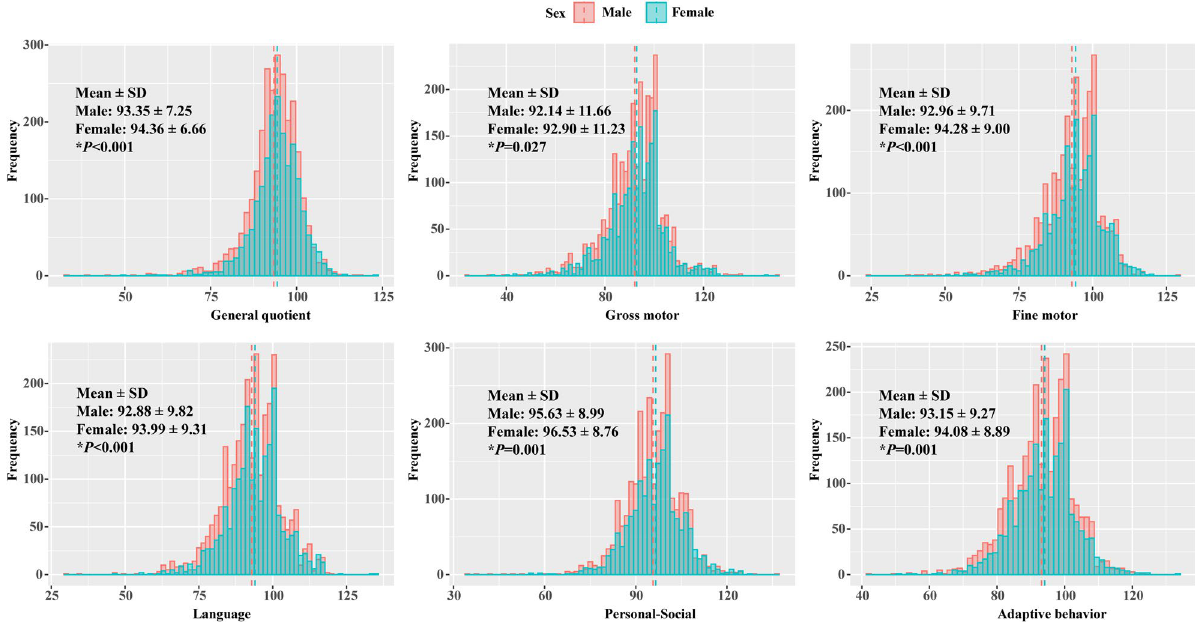
Figure 1. Distribution of CNBS-R2016 scores in different neurodevelopmental domains grouped by sex. Histograms depict the distribution of CNBS-R2016 scores for male (red) and female (blue) infants. The dashed lines in each histogram are the mean values. Differences in scores between males and females were determined by independent samples t-test. CNBS-R2016, Children Neuropsychological and Behavior Scale-Revision 2016.